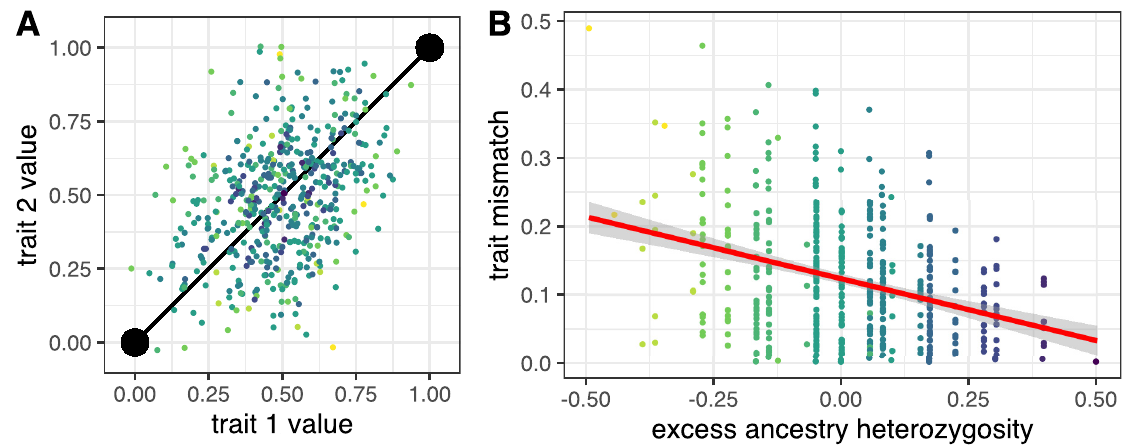
Fig 1. Results from simulations illustrating how an ecological mechanism could underlie the heterozygosity–incompatibility relationship in F 2 hybrids. Both panels depict results from a representative simulation run of adaptive divergence and hybridization between 2 populations. We consider an organism with 2 traits that have both diverged as a result of selection. Colored points are individual hybrids, with darker colors indicating higher heterozygosity. Panel (A) depicts the distribution of 500 F 2 hybrid phenotypes in two-dimensional trait space. Large black points are the 2 parent phenotypes, which are connected by a black line indicating the “axis of divergence.” Panel (B) depicts the relationship between individual excess ancestry heterozygosity and trait “mismatch” of individual hybrids [13]. Excess ancestry heterozygosity is the observed heterozygosity minus the expected heterozygosity based on ancestry proportion—0 is the expected mean in the absence of selection (approximately observed heterozygosity frequency of 0.5). Mismatch is calculated as the shortest (i.e., perpendicular) distance between a hybrid’s phenotype and the black line connecting parents in (A). Variation parallel to this axis connecting parents in (A) captures variation in the “hybrid index.” The plot shows that trait mismatch is lower in more heterozygous F 2 hybrids. Heterozygosity values are discrete because a small number of loci underlie adaptation in the plotted simulation run. Simulations are outlined in the Methods. The “mismatch”– heterozygosity relationship is stronger, although less intuitive, in organisms with greater dimensionality (i.e., more traits; see S1 Fig for a case with 10 traits following [18]). The data and code required to recreate this figure may be found at https://doi.org/10.5061/dryad.h18931zn3.